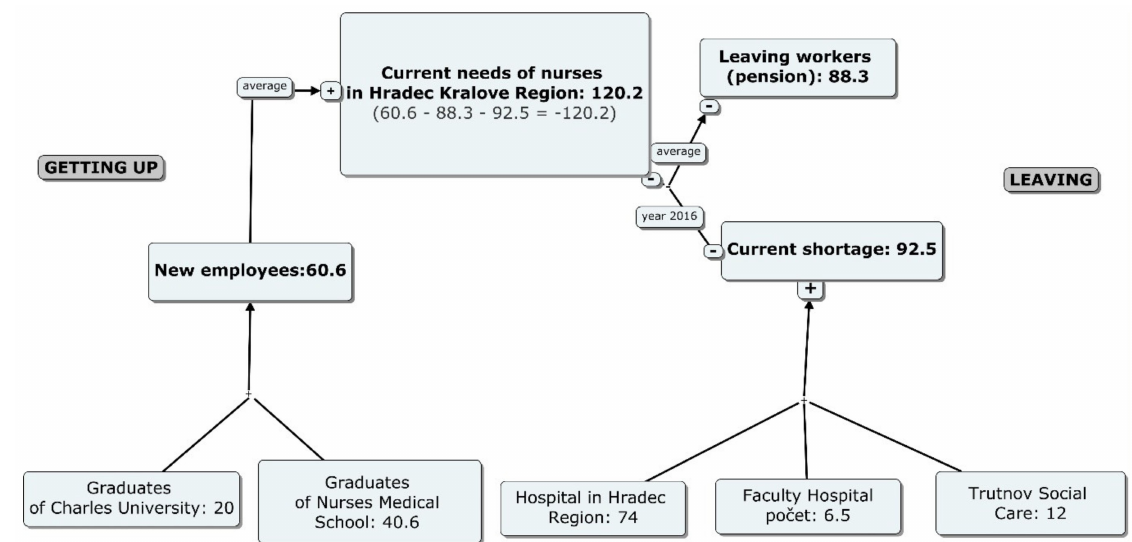
Figure 2. The need for nurses in Hradec Kralove region in